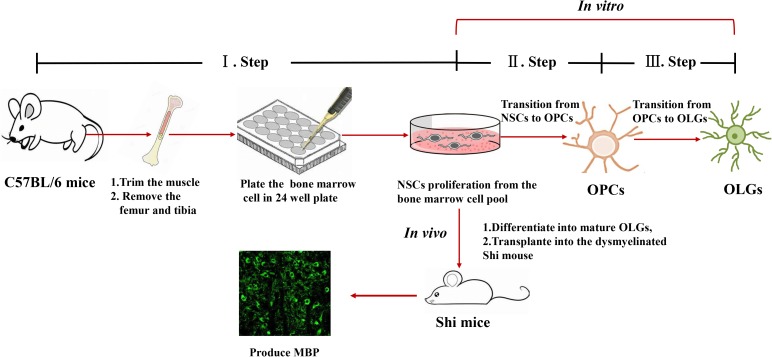
Representative scheme of the protocol for generating OPCs and OLGs from autologous mouse bone marrow-derived NSCs.